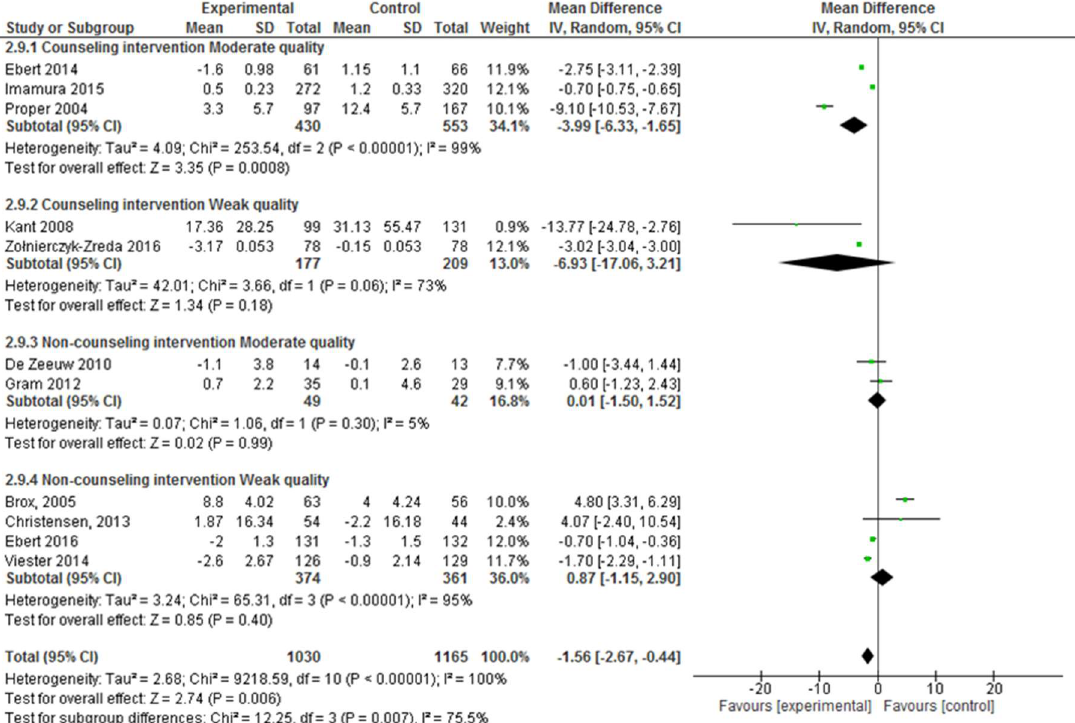
Figure 5. Forest plot of the effectiveness of workplace interventions for reducing absenteeism when considering whether the intervention included group or individual sessions and according to the quality of the studies.